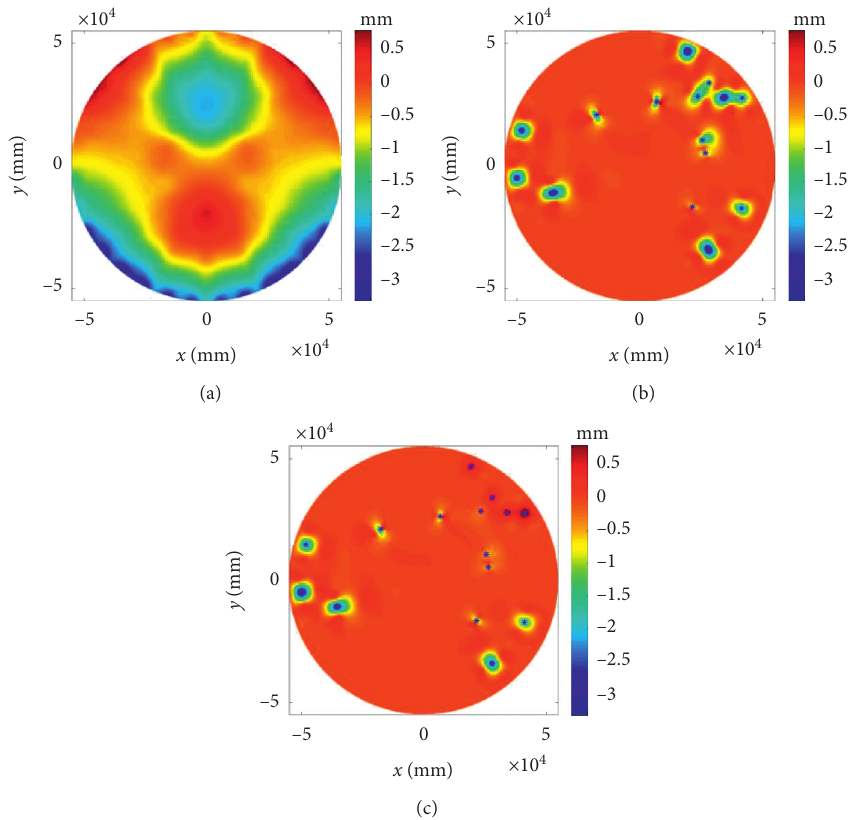
Figure 8: Compare with the main reflector deformation at 20deg elevation. (a) The reflector deformation before actuator failure. (b) The reflector deformation after actuator failure. (c) The reflector deformation at tolerance method.